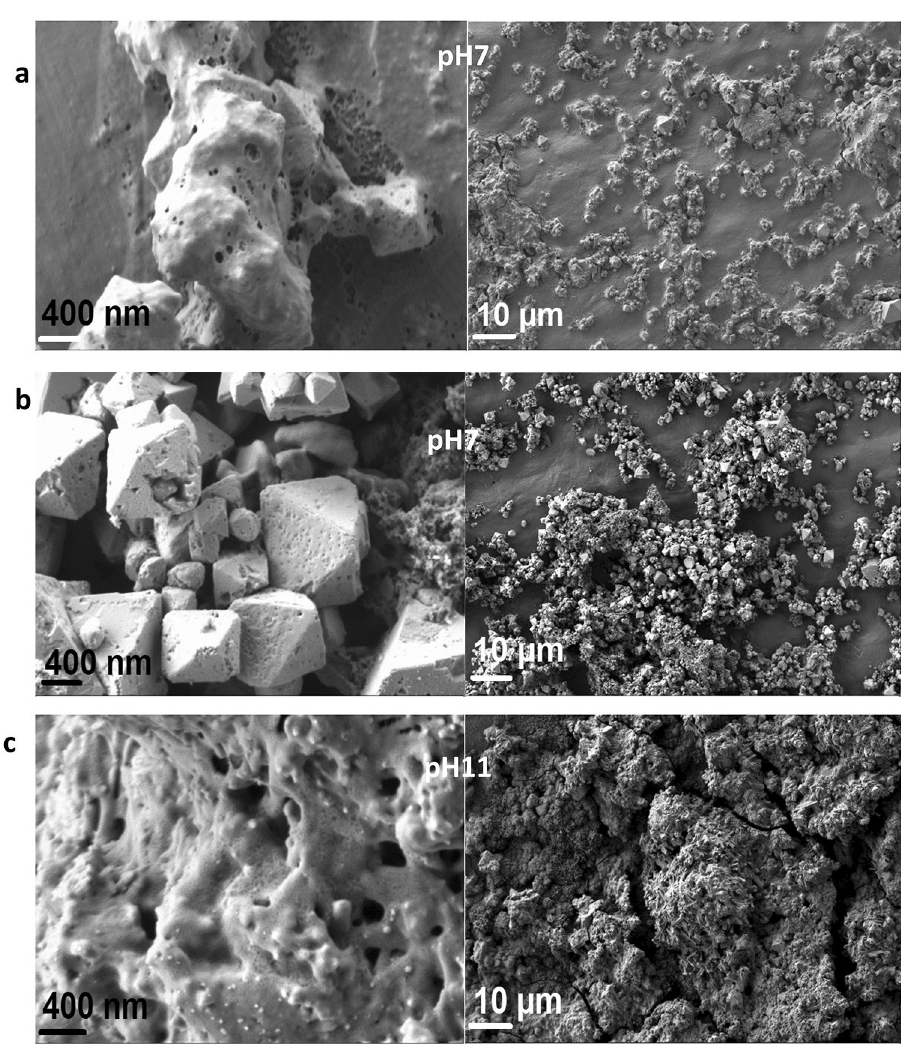
Figure 5. The corresponding FESEM micrographs for Cu-based oxide nanostructures prepared at ( a ) 60 (pH7), ( b ) 70 (pH7) and ( c ) 80 °C